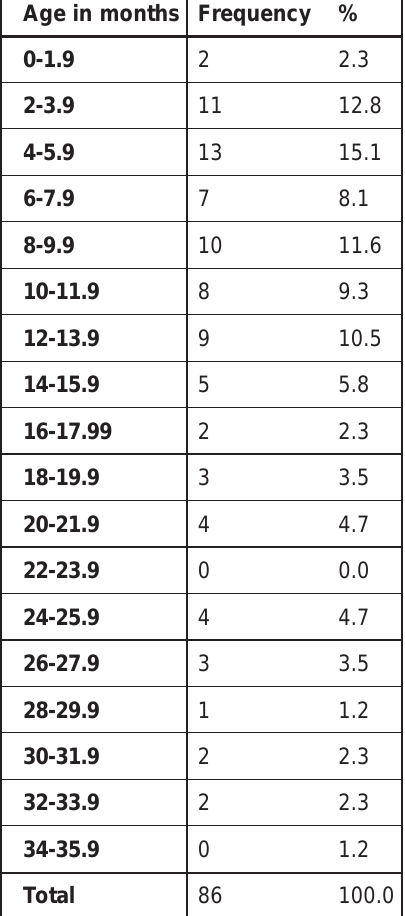
Table 1: Number of children in each two month age band.